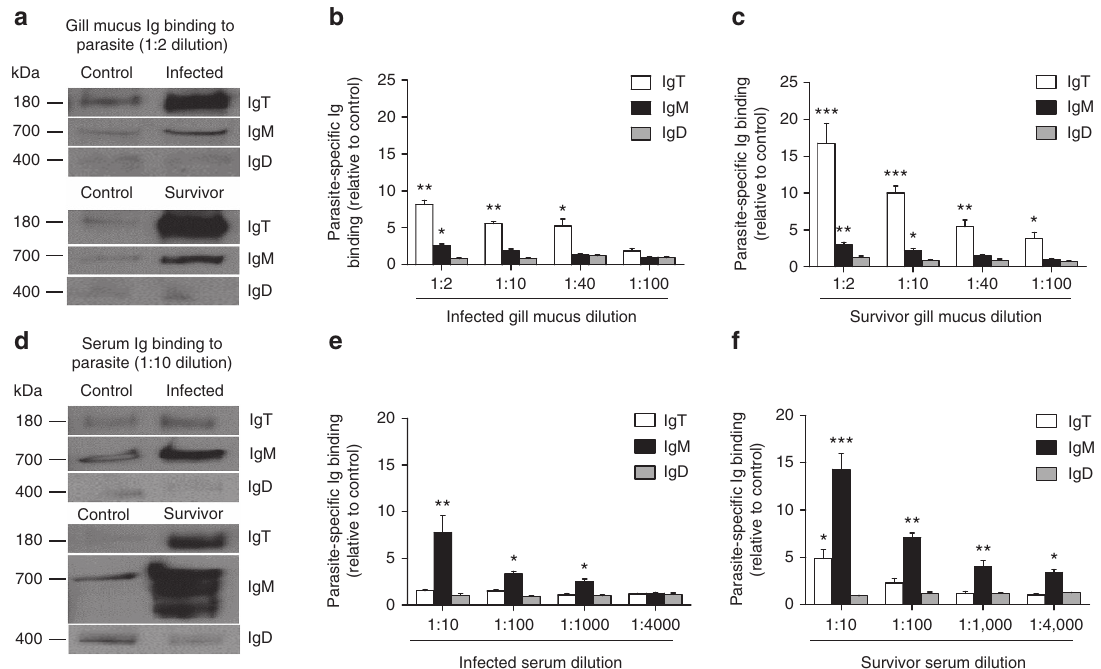
Figure 5 | Immunoglobulin responses in the gill mucus and serum from infected and survivor fish. ( a ) Western blot analysis of IgT-, IgM- and IgD- specific binding to Ich in gill mucus (dilution 1:2) from infected and survivor fish. ( b , c ) IgT-, IgM- and IgD-specific binding to Ich in dilutions of gill mucus from infected ( b ) and survivor ( c ) fish, evaluated by densitometric analysis of immunoblots and presented as relative values to those of control fish ( n ¼ 9 per group). ( d ) Western blot analysis of IgT-, IgM- and IgD-specific binding to Ich in serum (dilution 1:10) from infected and survivor fish. ( e , f ) IgT-, IgM- and IgD-specific binding to Ich in dilutions of serum from infected ( e ) and survivor ( f ) fish, evaluated by densitometric analysis of immunoblots and presented as relative values to those of control fish ( n ¼ 9 per group). * P o 0.05, ** P o 0.01 and *** P o 0.001 (unpaired Student’s t -test). Data are representative of at least three independent experiments (mean and s.e.m.).